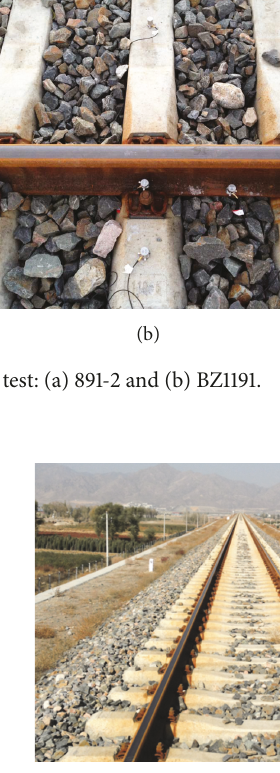
Figure 2: Test section on Ganqimaodu-Wanshuiquan heavy haul